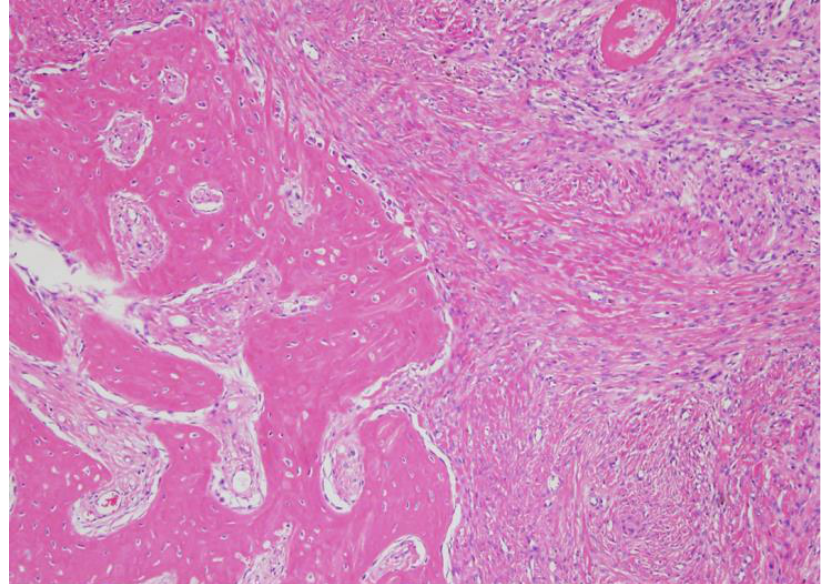
Figure 3. Cut surface of the resected specimen.